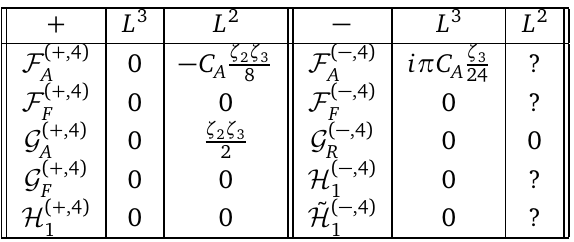
Table 1: Regge constraints separated by signature for the kinematic functions at four- loop order for 2 → 2 scattering in soft anomalous dimension ansatz of eq.